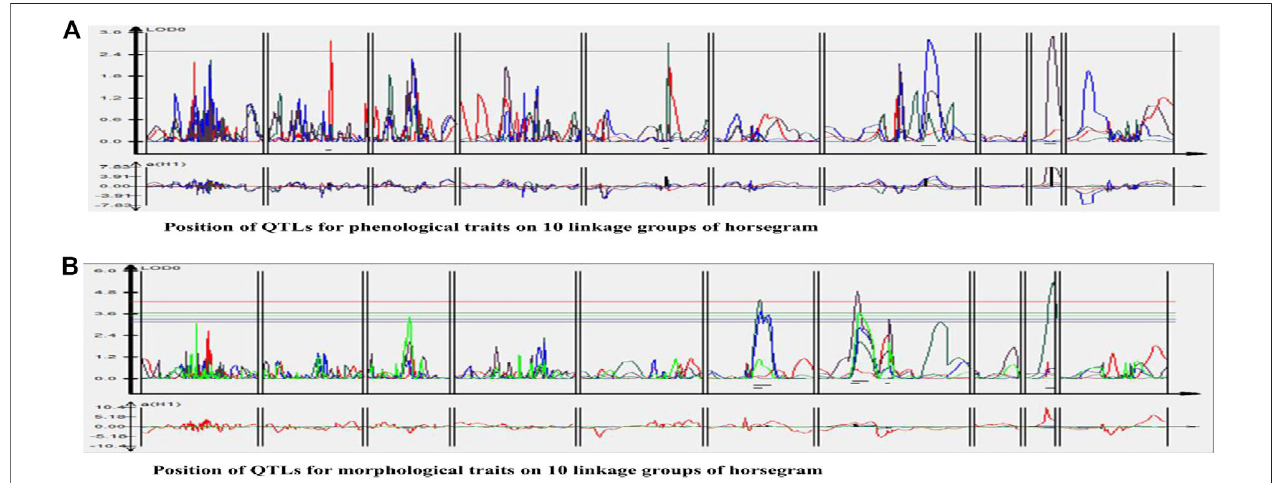
FIGURE 5 | Position of QTLs for (A) Phenological traits (B) Morphological traits on 10 linkage groups of